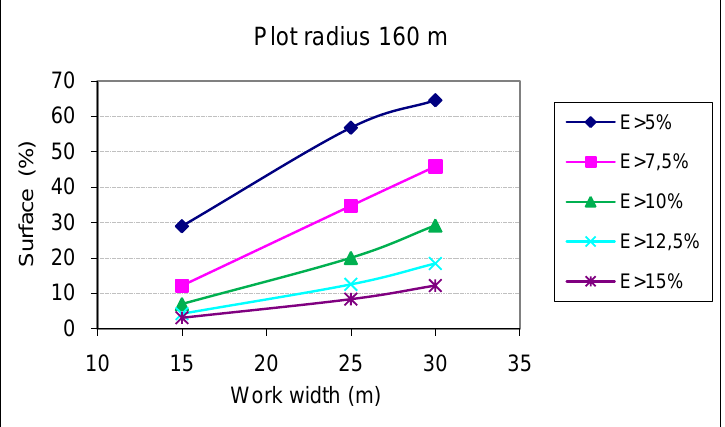
Figure 5. Percentage of surface area with errors (E) in the applied surface dose greater than 5%, 7.5%, 10%, 12.5% and 15% for the case of three sets of equipment with work widths of 15, 25 and 30 m carrying out treatment in circular trajectories in a circular plot with a 160 m-in radius at a displacement velocity of 7 km/h and a nominal nozzle flow of 1.4 L/min.